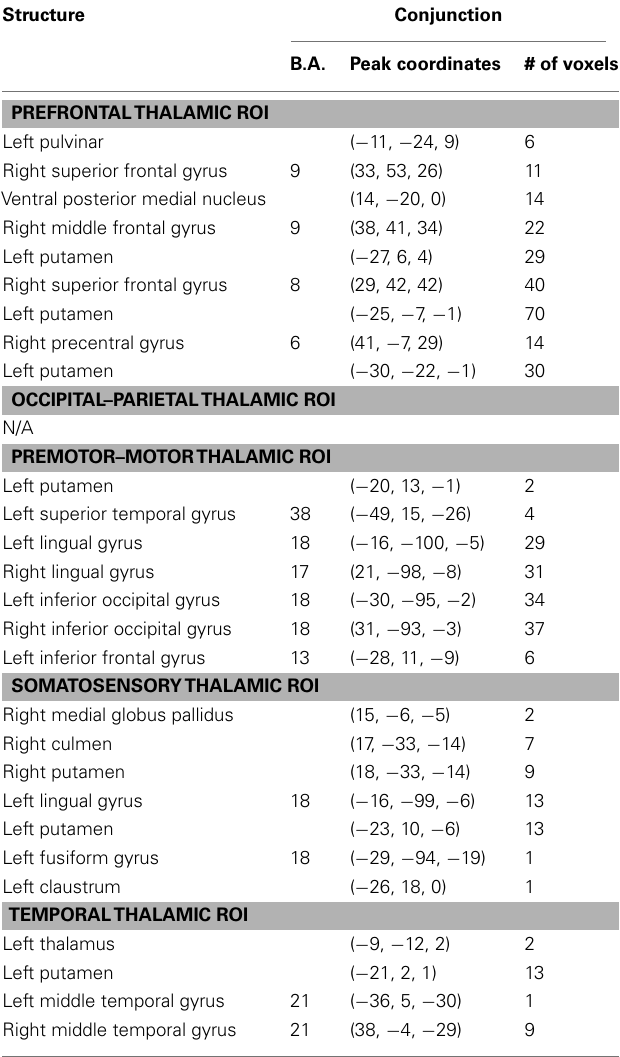
Table 2 | Peak coordinate for the conjunction